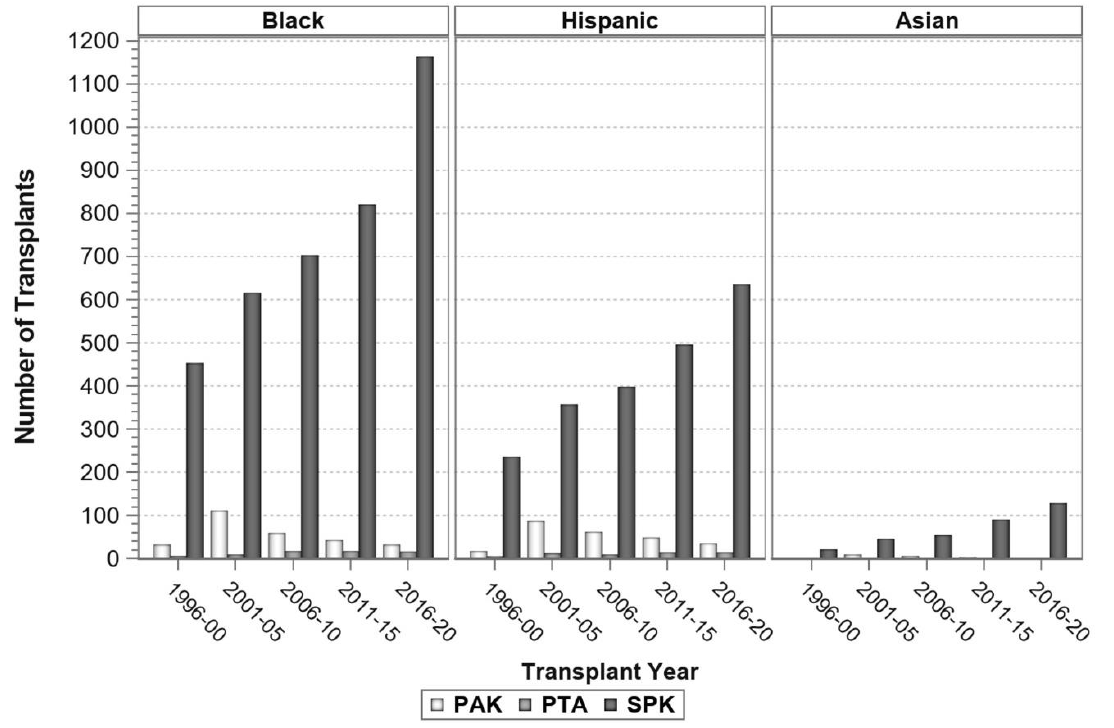
Figure 2. Proportion of African American recipients by year according to PTx category for US cases as reported to the IPTR.